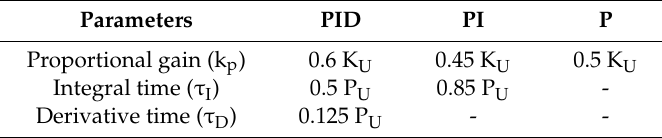
Table 2. Tuning rule for the maintained oscillation